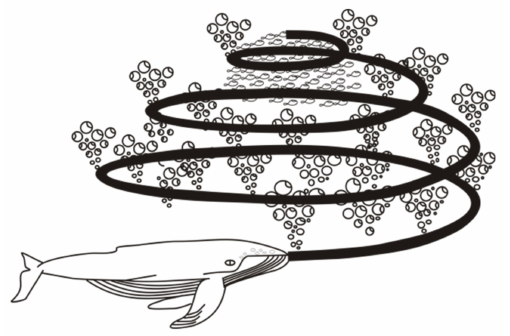
Figure 1. Bubble-net feeding behavior of humpback